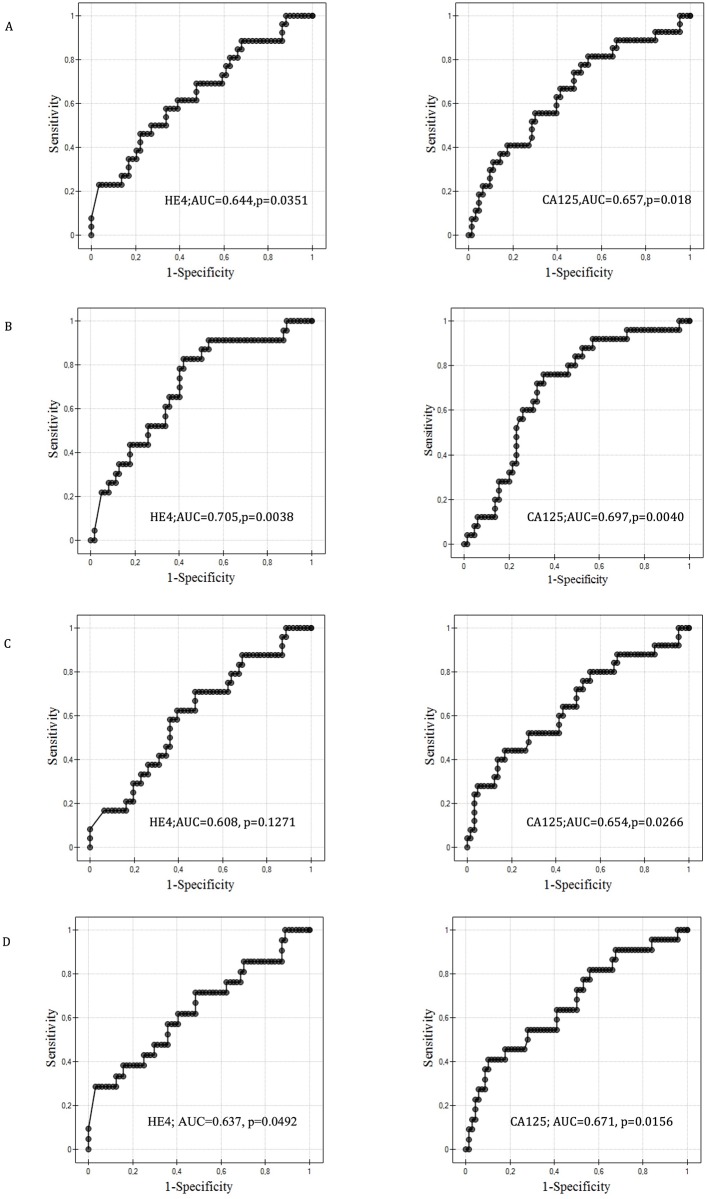
ROC of the plasma HE4 and CA125 for the prediction of maximal cytoreduction, platinum sensitivity, two-year survival and disease-free survival.(A) Platinum sensitive vs. platinum resistant. (B) Maximal cytoreduction vs. suboptimal debulking. (C) Reached two-year survival vs. did not reach two-year survival. (D) Reached disease-free survival vs. did not reach disease-free survival.